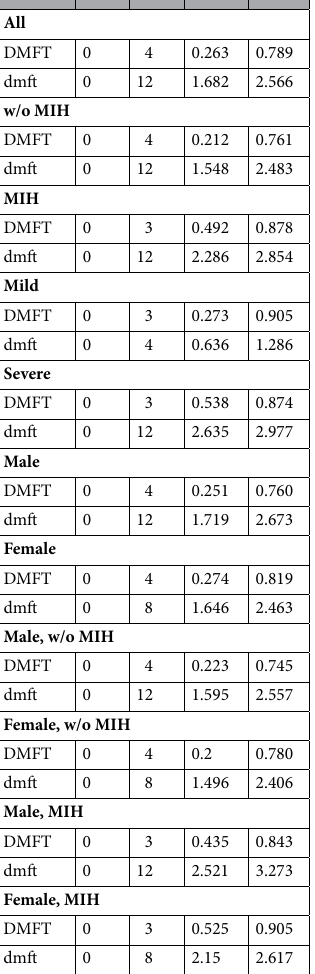
Statistical analysis. The R statistical program, ver. 4.1.2 (The R Foundation for Statistical Computing, Wirtschaftsuniversität Wien, Vienna, Austria) was used for the statistical analyses. The results were considered statistically significant at p < 0.05. Logistic model. Factors influencing probability of MIH were selected from perinatal factors for etiology, gender, geographic area of origin. Geographic area of origin was restricted to Europe/non-Europe due to small number of patients from other geographical areas. Logistic regression was used, the optimal model was selected by Akaike information criterion value (AIC). The patient’s gender was the only variable in optimal model, it showed significant influence on the probability of MIH (Table 4). Log of odds ratio was 0.645 lower for male than for female patients. Factors influencing probability of severe form of MIH were also examined. No factors with significant influence were detected. Significance of the difference in DMFT, visible plaque and IOTN > 3 between groups without/with MIH is presented in the Table 5. DMFT and visible plaque were significantly larger in the group with MIH than w/o it (all the patients and female patients only). IOTN > 3 cases were significantly larger in the group with MIH than w/o it for male patients.